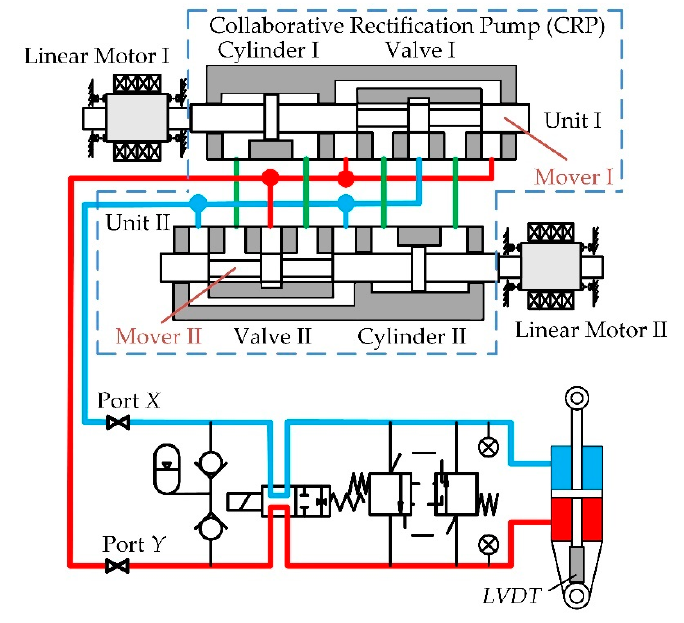
Figure 1. The schematic of the actuator and the collaborative rectification linear pump with two units indicated within the dashed line [23].